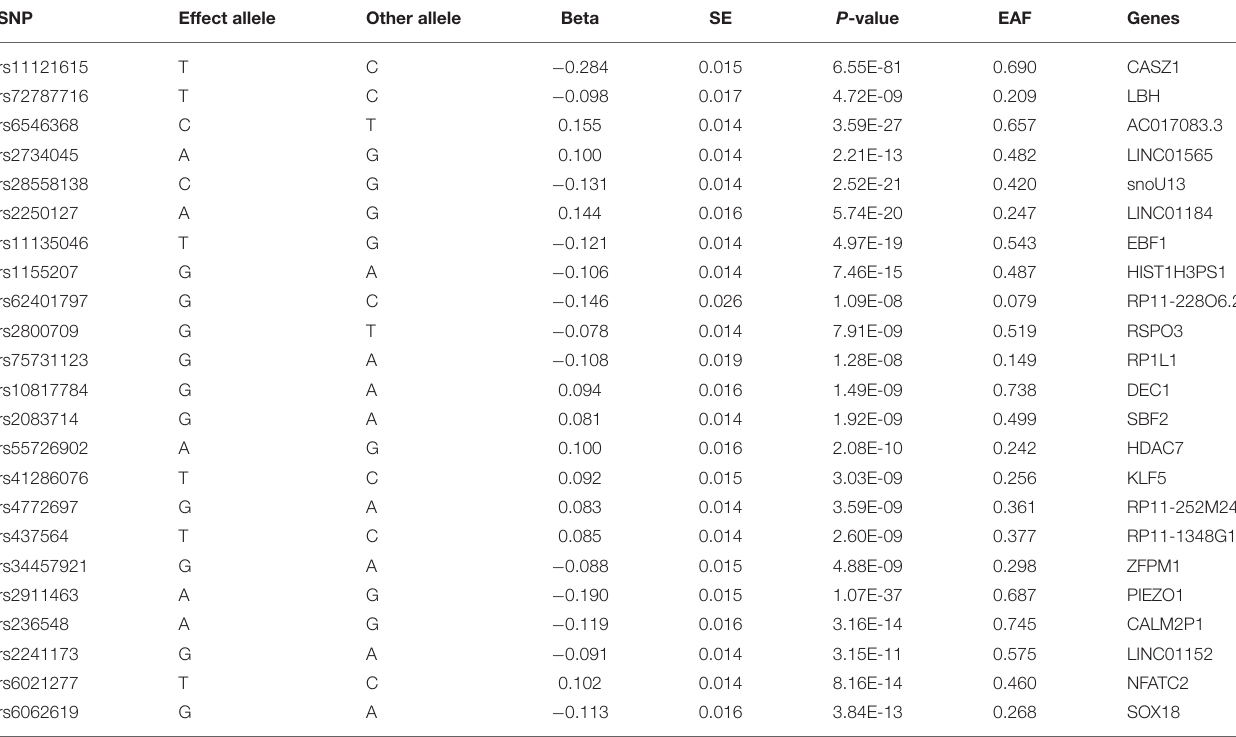
TABLE 1 | Details of SNPs selected as instrumental variables.